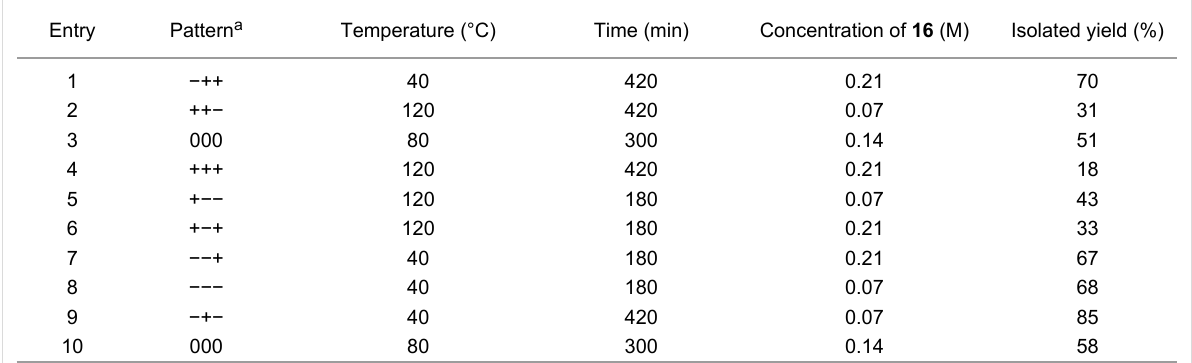
Table 2: 1 st Full factorial screening for conversion of compound 16 .